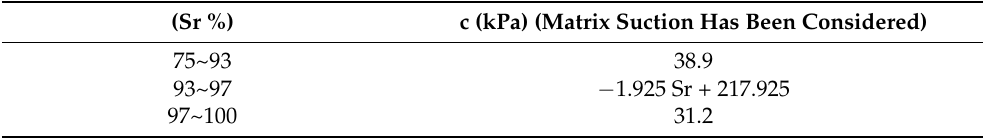
Table 1. Values of cohesion parameters.